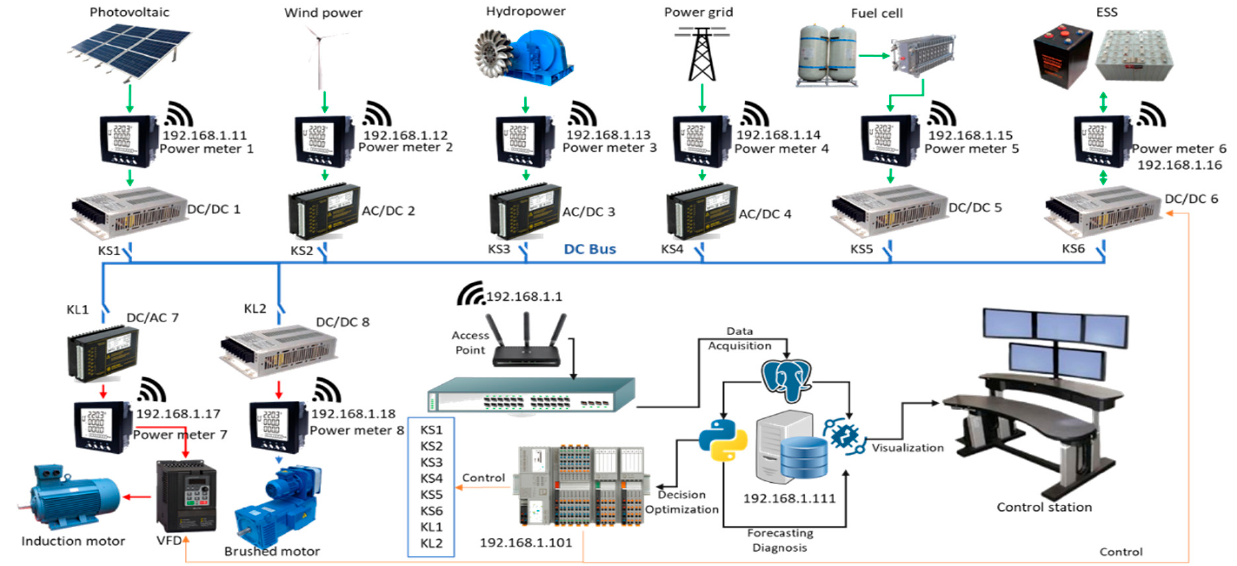
Figure 20. Conceptual architecture of the control system of the test bench.